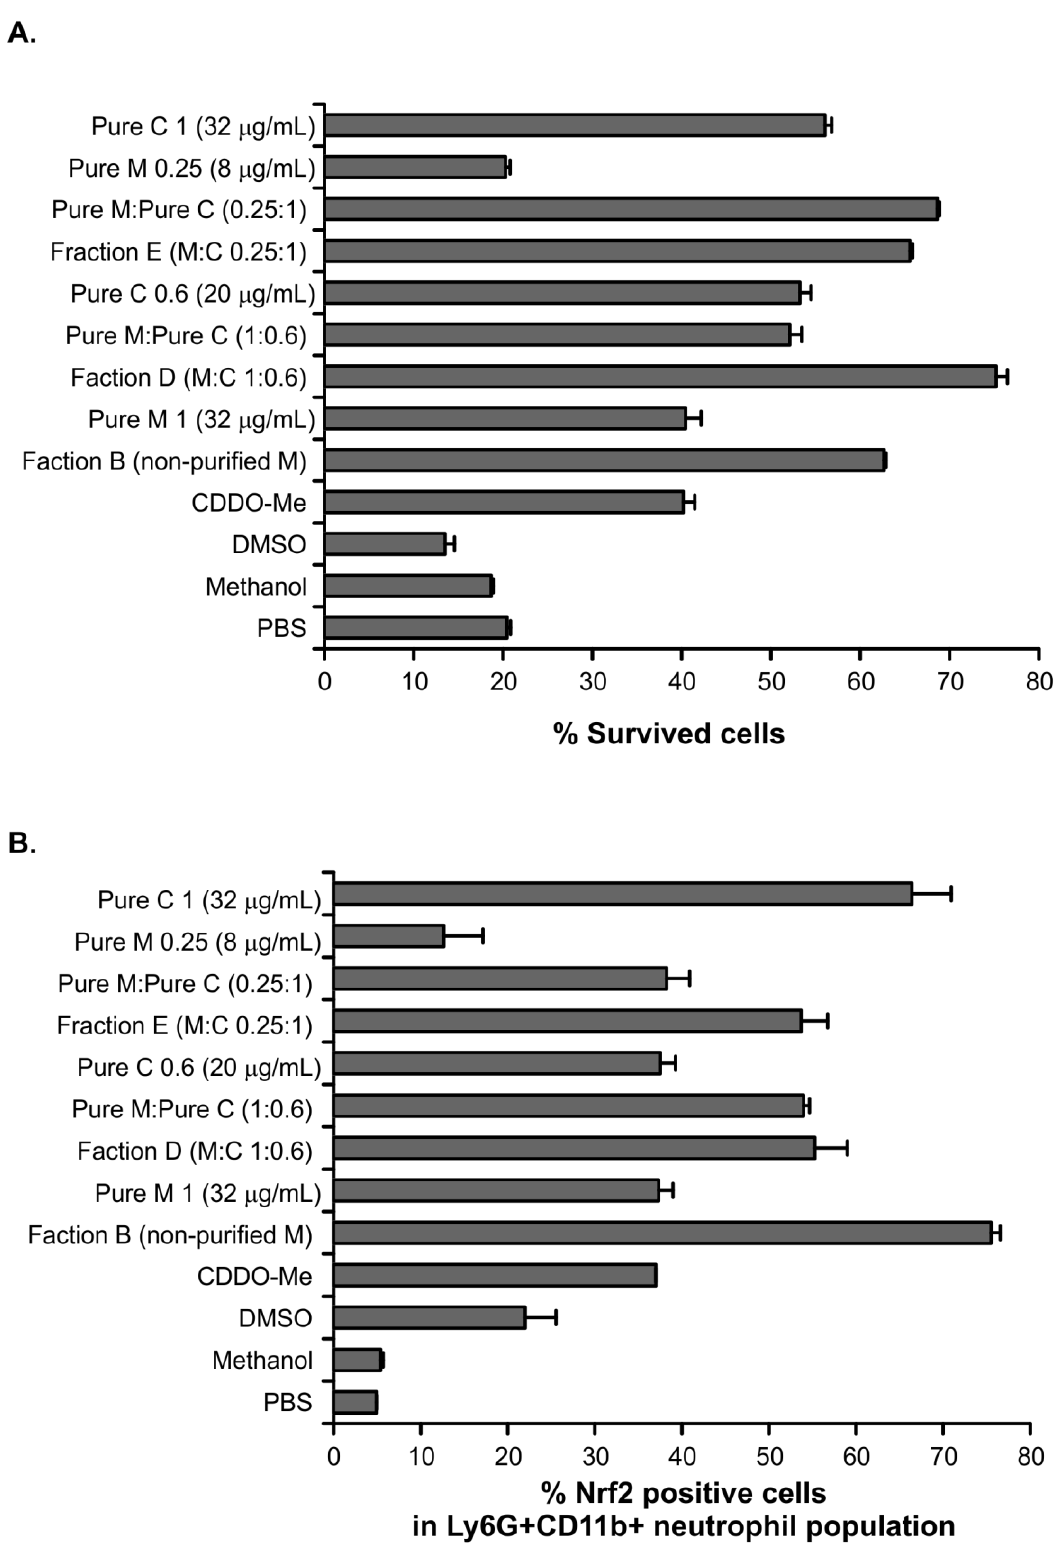
Figure 4. The effect of myconoside and calceolarioside E in the fractions on the percentage of viable ( A , B ) Nrf2 + cells in Ly6G + CD11b + neutrophils. ( A ) The percentage of viable neutrophils was evaluated after 16 h of culturing in the presence of the fractions or pure compounds present alone or together at a particular proportion; myconoside (M) and calceolarioside E (C). The percentage of cell viability was calculated upon the Trypan blue exclusion of dead cells. ( B ) The percentage of Nrf2 + cells in mature neutrophils evaluated by flow cytometry. The data represent the mean ± standard deviation (SD) run in duplicates.